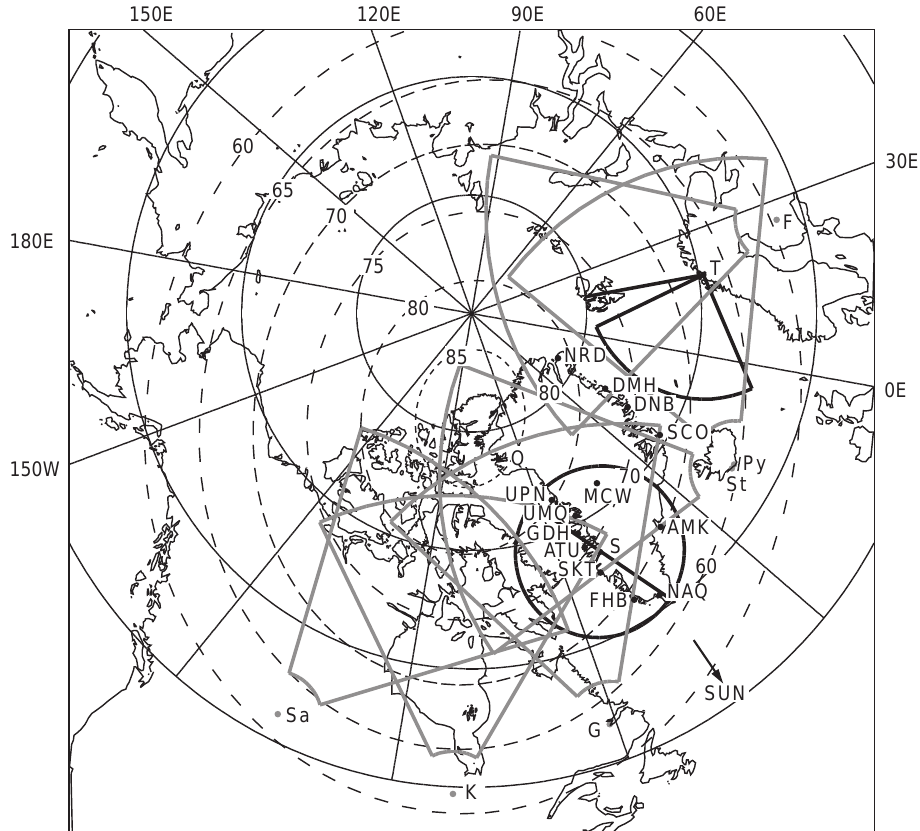
where the radars and magnetometers of the Greenland chain are placed. Their geographic locations are as follow: Q =